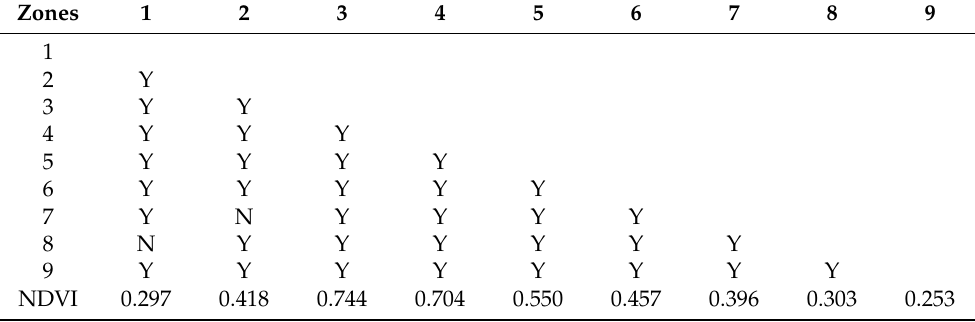
Table 12. Mean NDVI values and significant differences between two regions in terms of elevation.